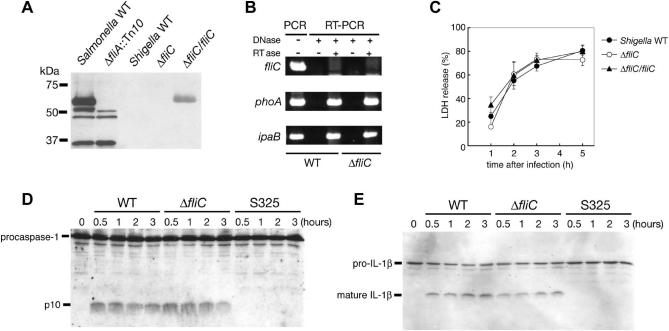
Flagellin-Independent Caspase-1 Activation and Pyroptosis in Shigella-Infected Macrophages(A) Immunoblot for FliC expression. Bacterial whole cell lysates were loaded from S. typhimurium strains: wild-type (WT), flagellar mutant (fliA::Tn10); or S. flexneri strains: WT, flagellin mutant (ΔfliC), flagellin overexpressor (ΔfliC/fliC).(B) RT-PCR for fliC mRNA expression in Shigella. As the controls, phoA or ipaB expression was examined.(C) LDH release from BMMs infected with Shigella WT, ΔfliC, or ΔfliC/fliC. Error bars represent mean ± SD.(D) Activation of caspase-1, assessed by immunoblot for the processed p10 fragment after infection with Shigella WT, ΔfliC, or TTSS mutant (S325).(E) Processing of IL-1β, assessed by immunoblot. Results are representative of three experiments.